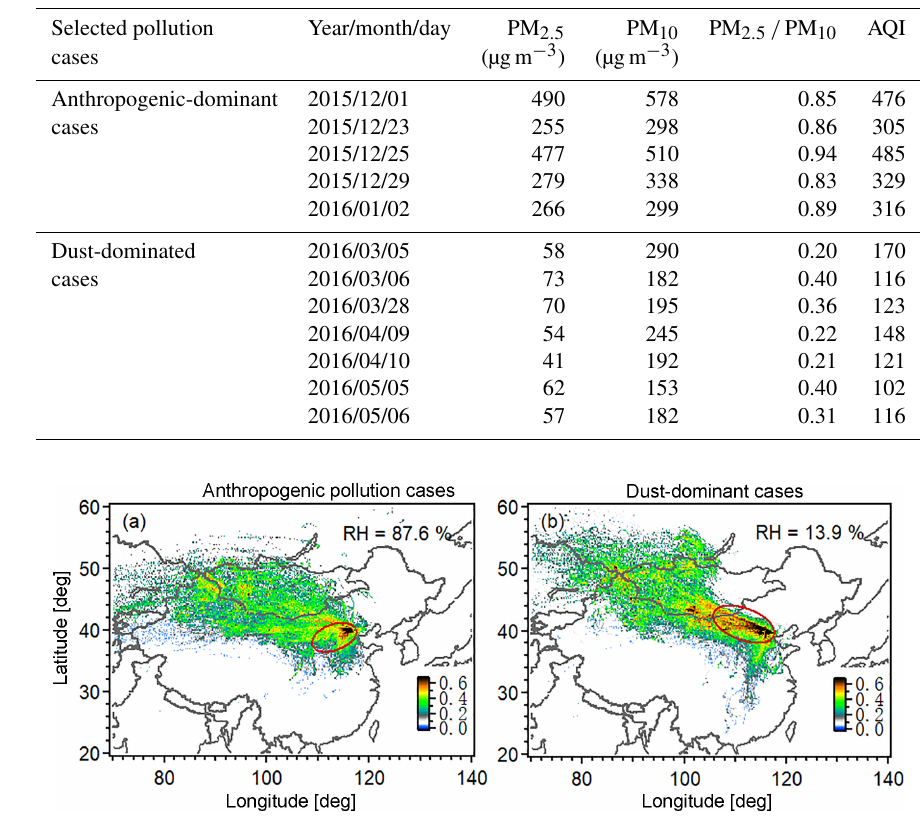
Figure 4. Proportion of different directions from which the air mass over Beijing originated in varying pollution types: (a) the severe anthropogenic-pollution-dominant case and (b) the dust-dominant case. The red ellipse represents the major source region of air mass arriving at the